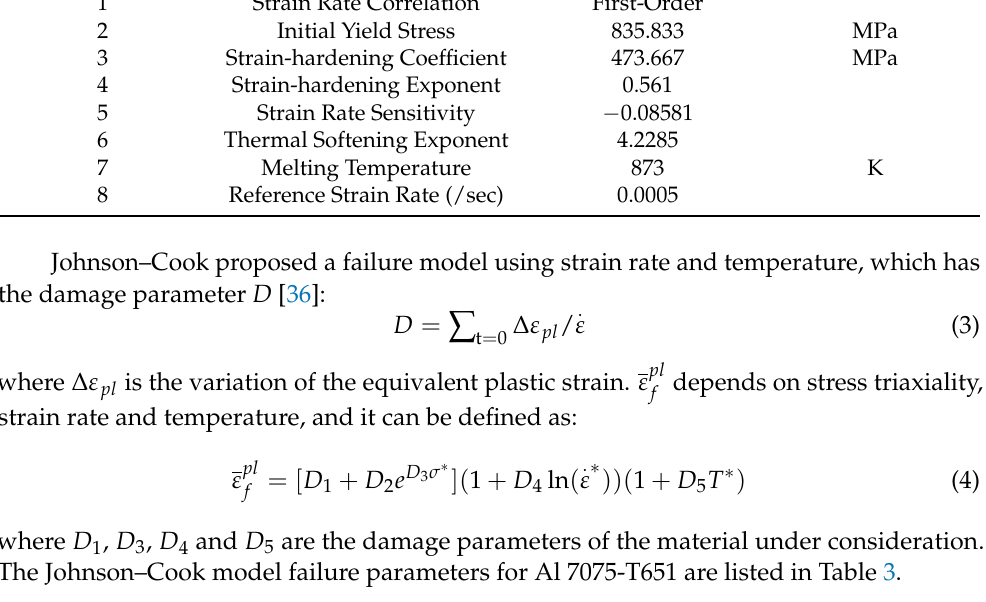
Table 3. Johnson–Cook failure model parameters for Al 7075-T651